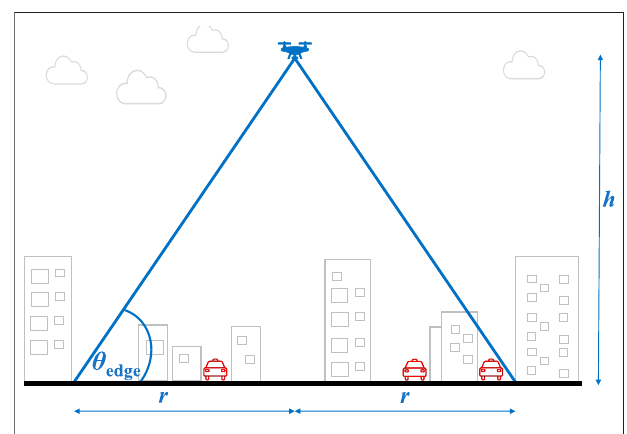
FIGURE 3 | Illustration of the drone position and geometry, in the communications